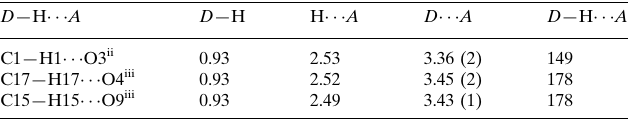
Hydrogen-bond geometry (A˚ , (cid:4)